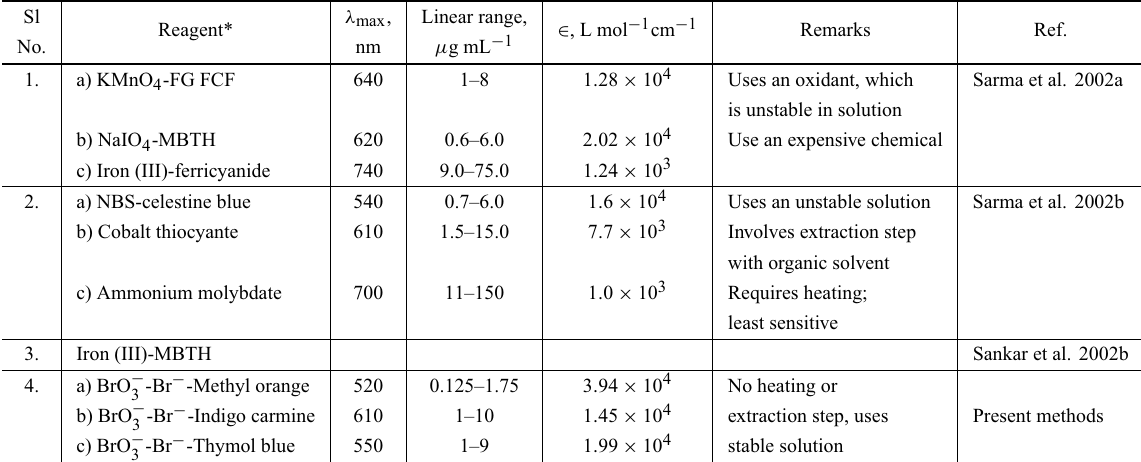
Comparison of performance characteristics of proposed methods with the existing spectrophotometric methods.